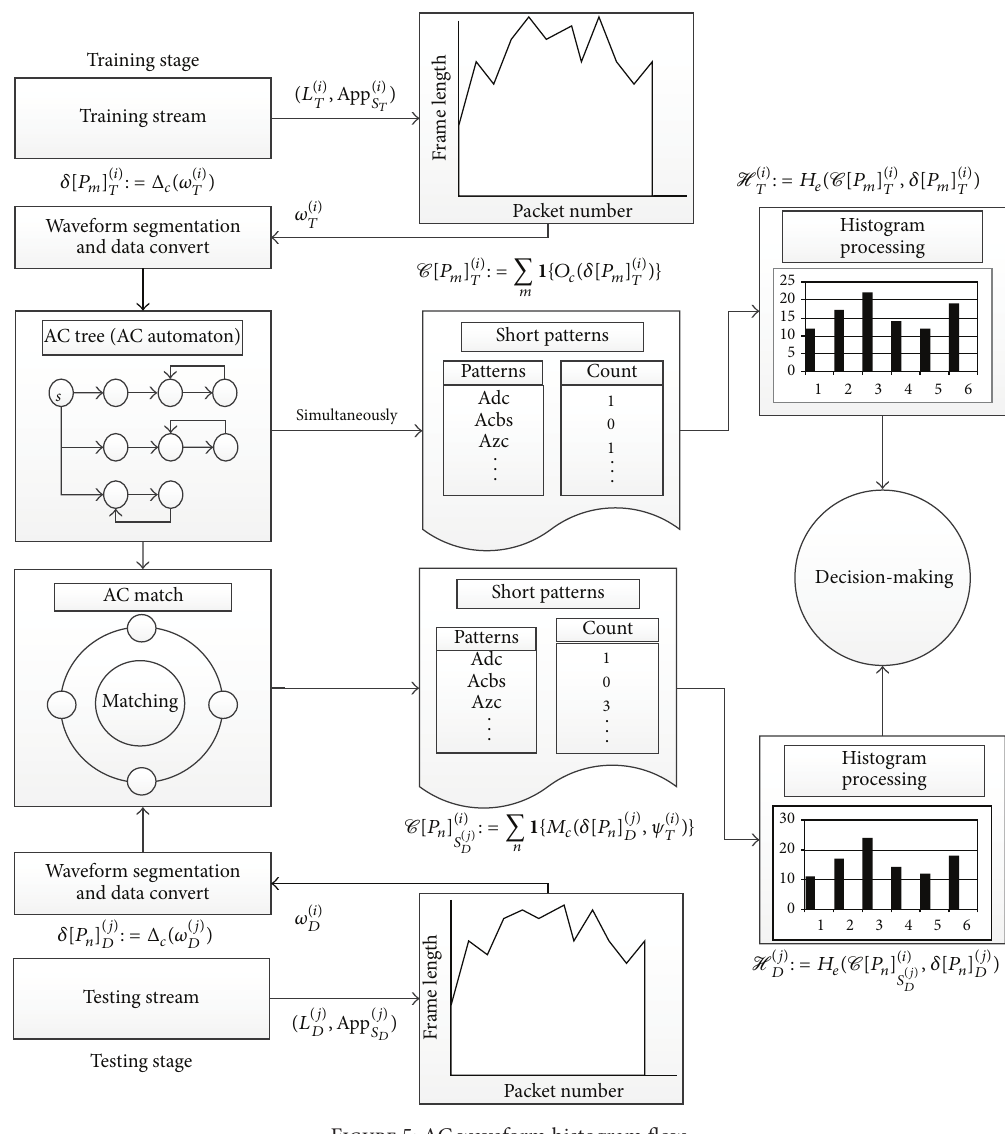
Figure 5: AC waveform histogram flow.